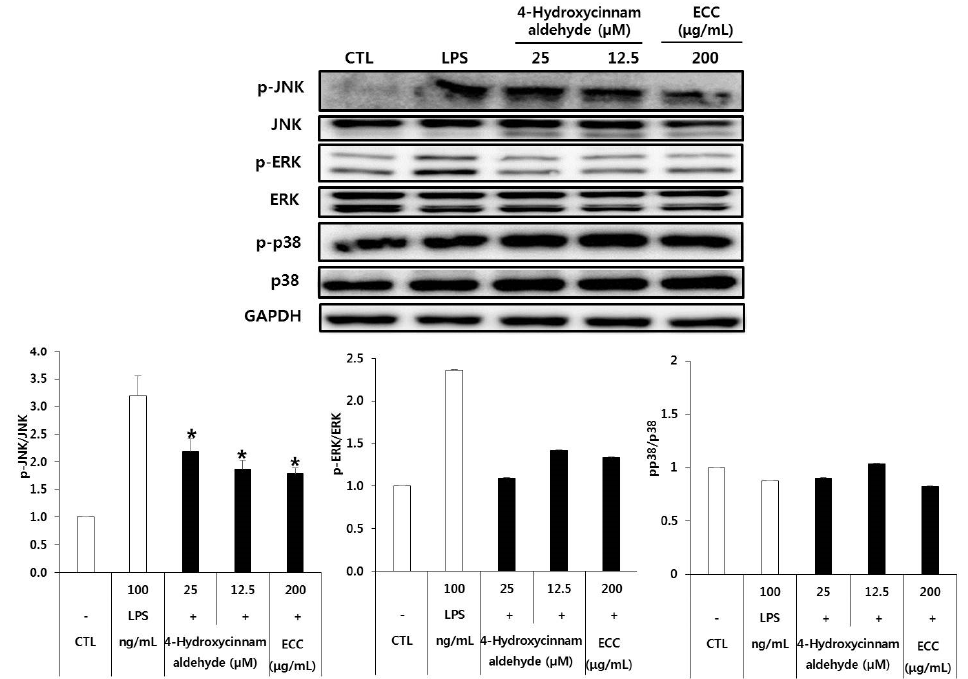
Figure 7. Effect of ECC and 4-hydroxycinnamaldehyde on LPS-activated phosphorylation of the MAPK pathway in macrophages. RAW 264.7 cells were treated with samples for 2 h, followed by treatment with LPS for 22 h. Total cellular extracts were examined for the indicated antibodies using Western blot analysis. Quantification of p-JNK, p-ERK, and p-p38 was normalized to JNK, ERK, and p38 using image J. The data are the means ± SD of at least three separate experiments. * p < 0.05 compared to the LPS group.